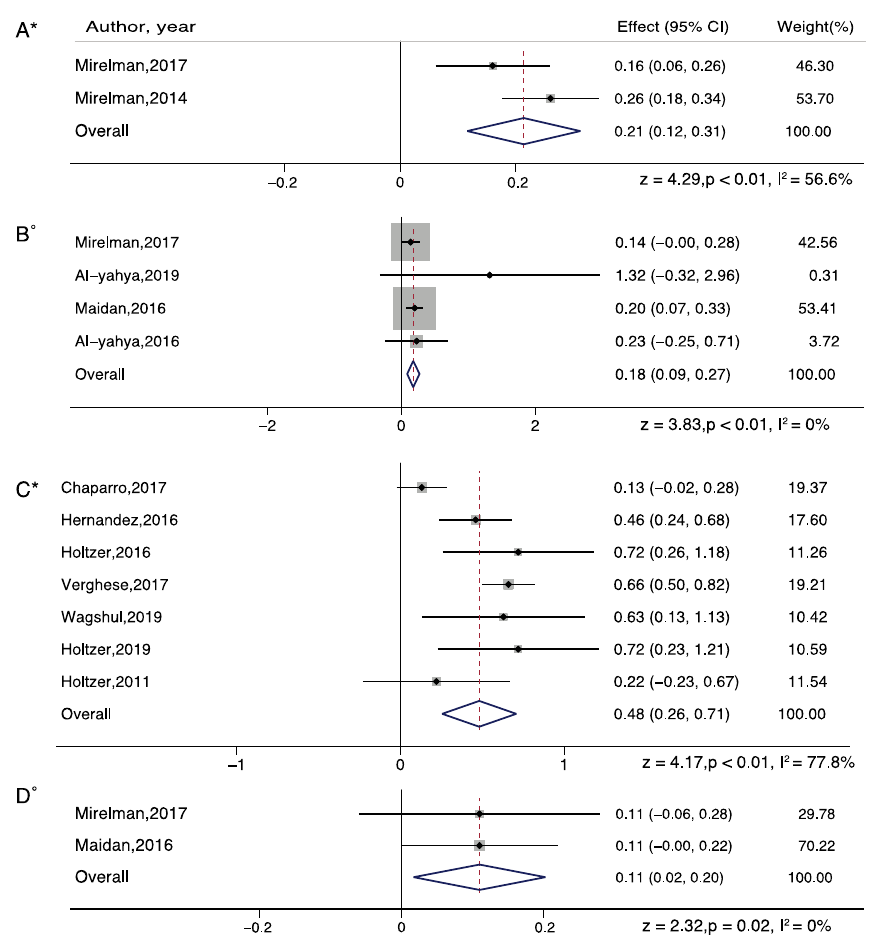
Figure 4. Brain activation differences while doing letter generation task ( A ) and serial subtraction task ( B , C ) in older adults with neurological diseases (multiple sclerosis-A, Parkinson’s disease-B, stroke-C). Note: ° represents Fixed plot meta-analysis, * represents Random plot meta-analysis.